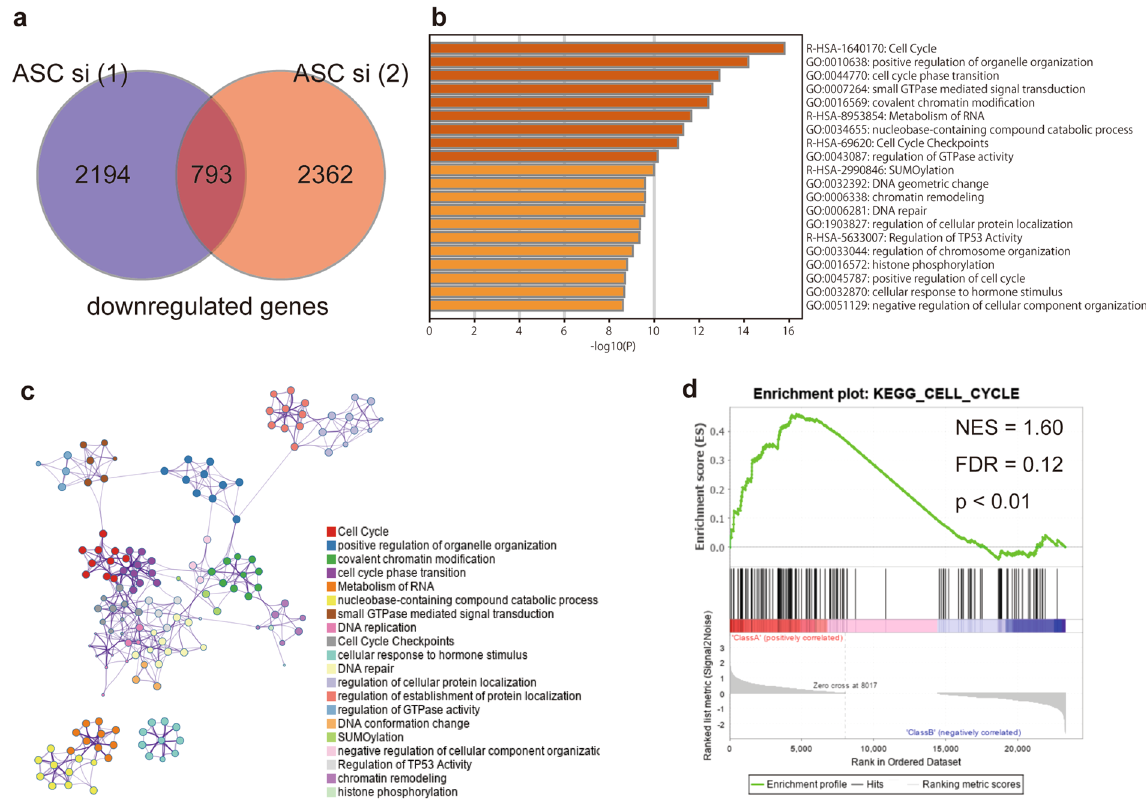
Figure 5. Functional enrichment analysis using Metascape and GSEA. ( a ) Venn diagram showing overlapping RNAs detected via RNA-seq analysis of downregulated RNAs at 72-h post-transfection of either ASC (1) or (2) siRNA and relative to control siRNA-transfected PANC-1 cells. ( b ) Functional enrichment results. Heatmap showing the top 20 clusters colored according to the p-value (darker color indicates a lower p-value). ( c ) Network of the top 20 clusters of enriched terms. Each node indicates an enrichment term colored by cluster ID. Nodes sharing the same cluster are generally located in close proximity. Terms with a kappa similarity ≥ 0.3 are connected. ( d ) GSEA for the gene signature of KEGG_CELL_CYCLE. NES normalized enrichment score, FDR false discovery